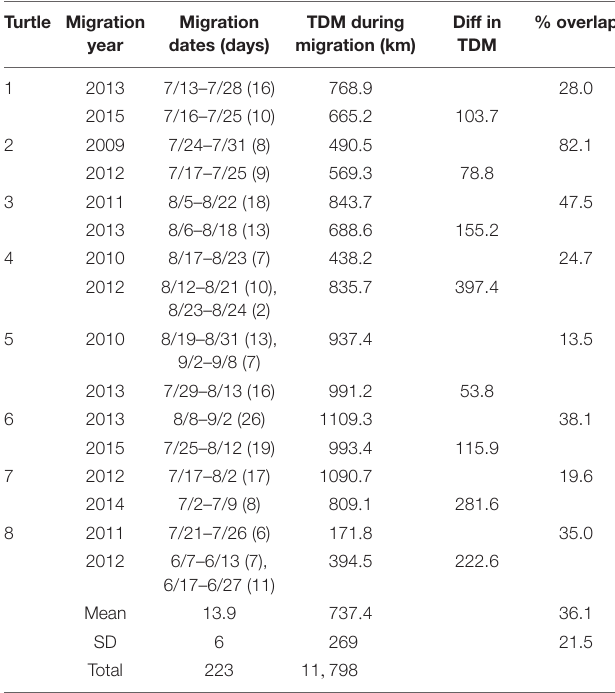
TABLE 3 | Migration details for loggerhead sea turtles ( Caretta caretta ) tracked from nesting grounds